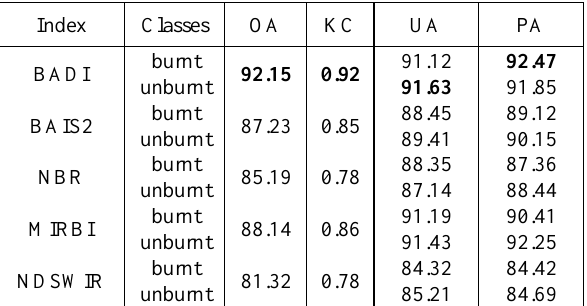
Table 4. The accuracy assessment of the wildfire